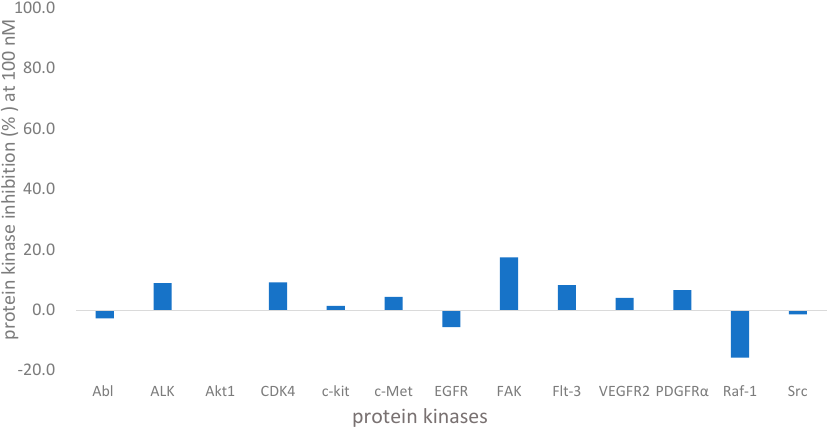
Figure 4. Selectivity profile of compound 9E on 13 protein kinases at 100 nM.